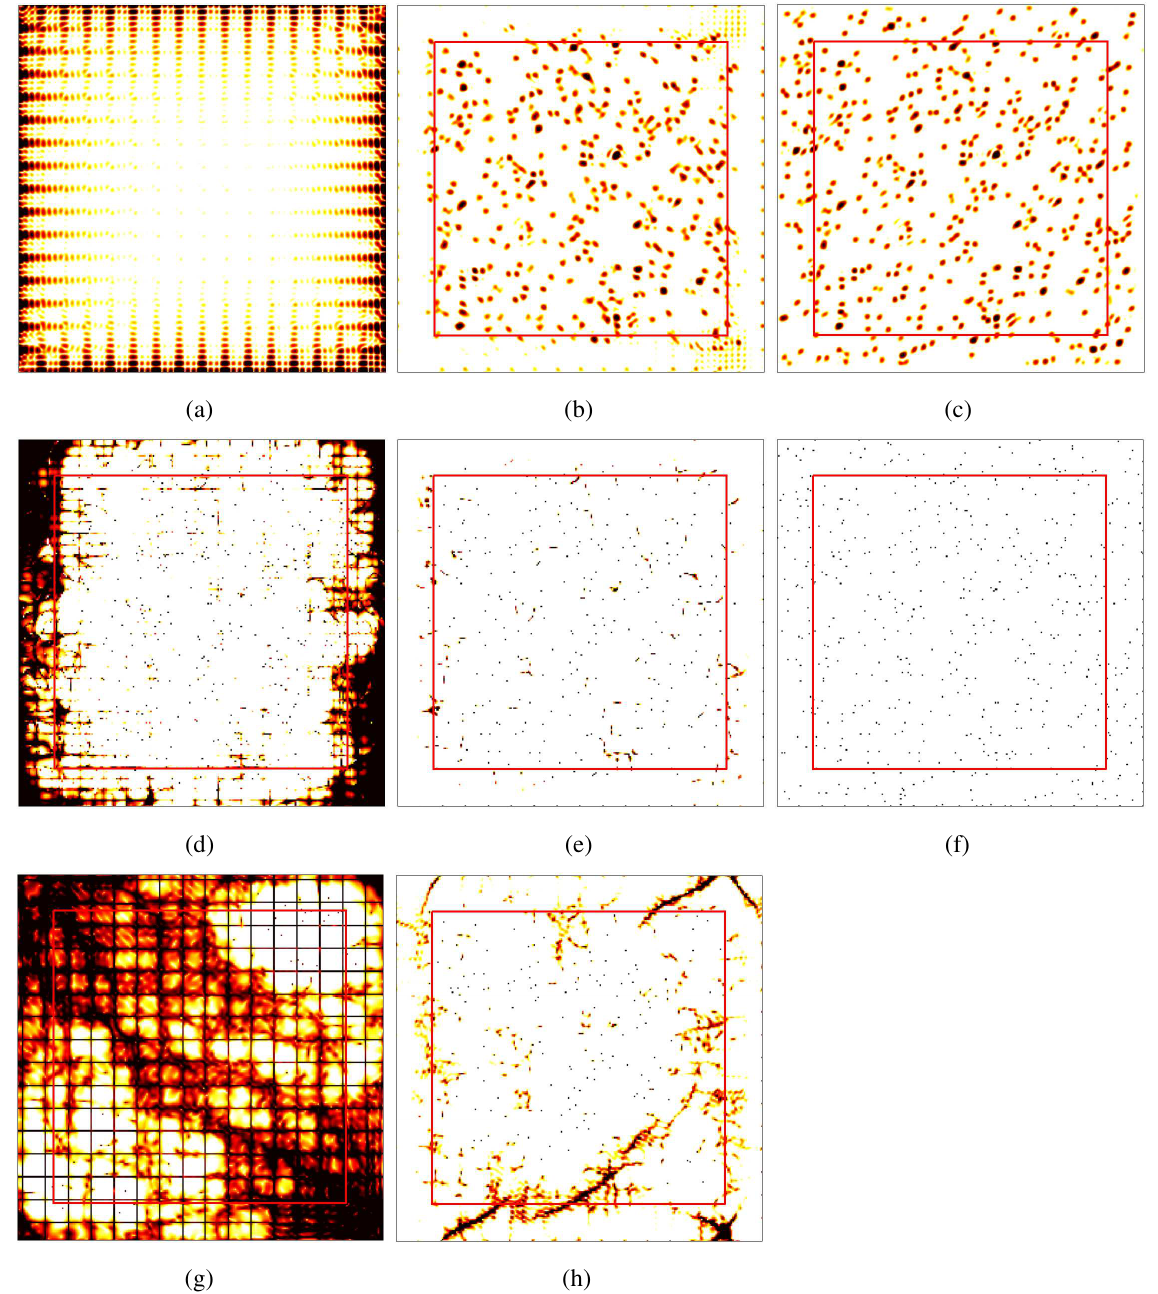
Figure 10. Sub-band decomposition and spectral estimation within the analyzed region: ( a ) the Fourier spectrum of x ; ( b ) the Fourier spectrum of decomposed sub-band signal n 1 ,n 2 based on our method; ( c ) the Fourier spectrum of s p 1 q ; ( d ) the amplitude and phase n 1 ,n 2 estimation (APES) result of (a) corresponding to the ideal frequency domain filters-based sub-band decomposition; ( e ) the APES result of (b); ( f ) the actual spectrum; ( g ) the iterative adaptive approach (IAA) result of (a); ( h ) the IAA result of